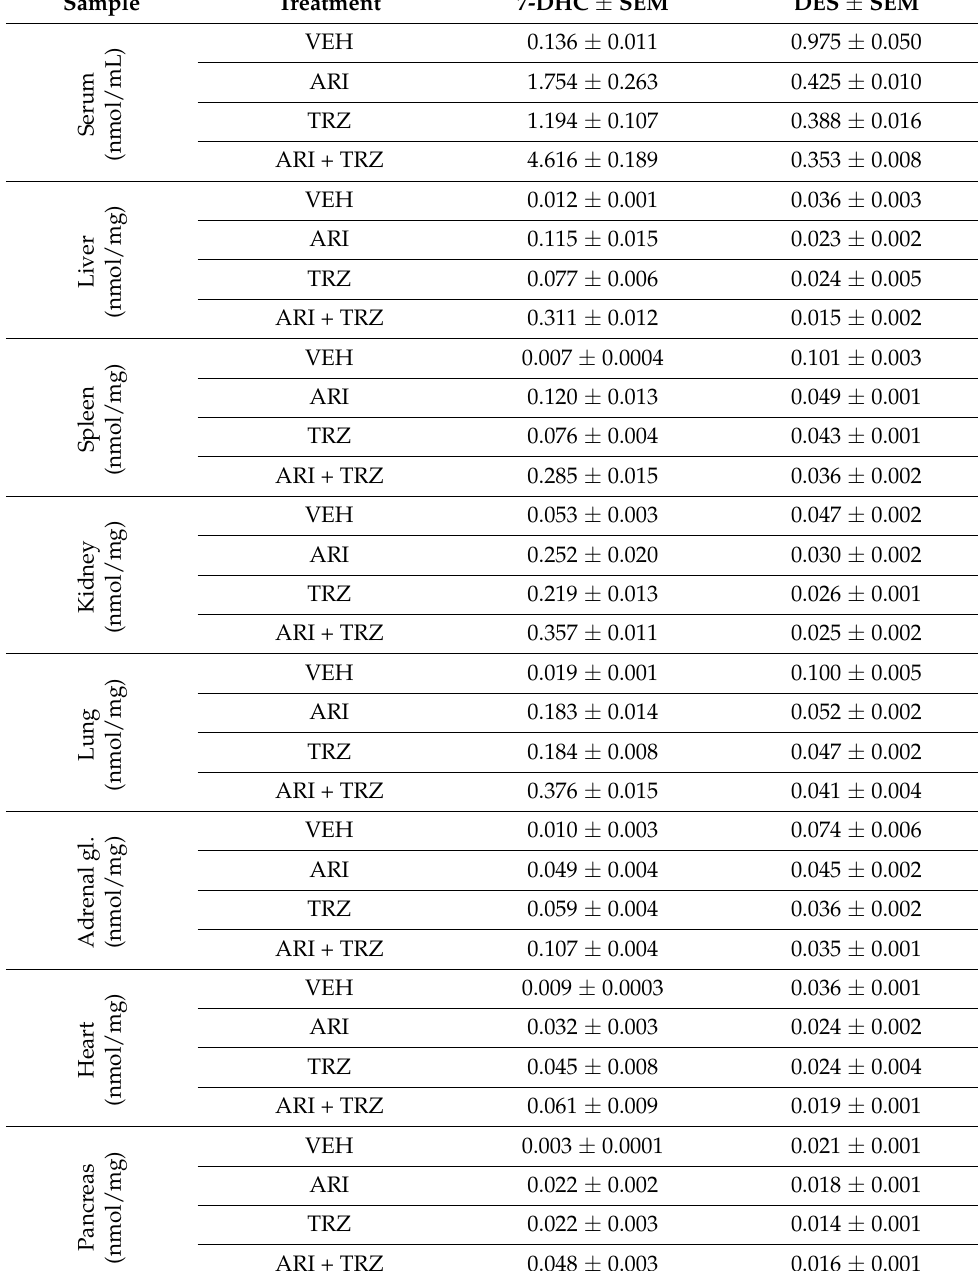
Table 1. Sterol levels in serum and peripheral organs of mice treated with ARI, TRZ, or ARI + TRZ. Serum levels are expressed as nmol/ml ± SEM, values for all organs are expressed as nmol/mg of protein ±